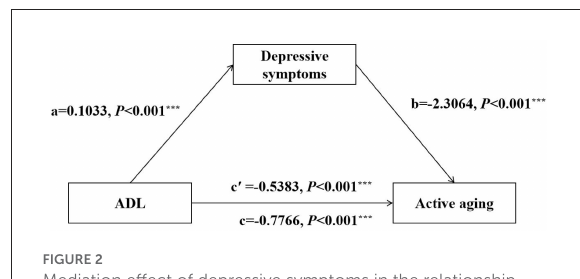
FIGURE2 Mediation effect of depressive symptoms in the relationship between ADL and active aging. ADL, activities of daily living. The *** symbol indicates the value of P < 0.001.